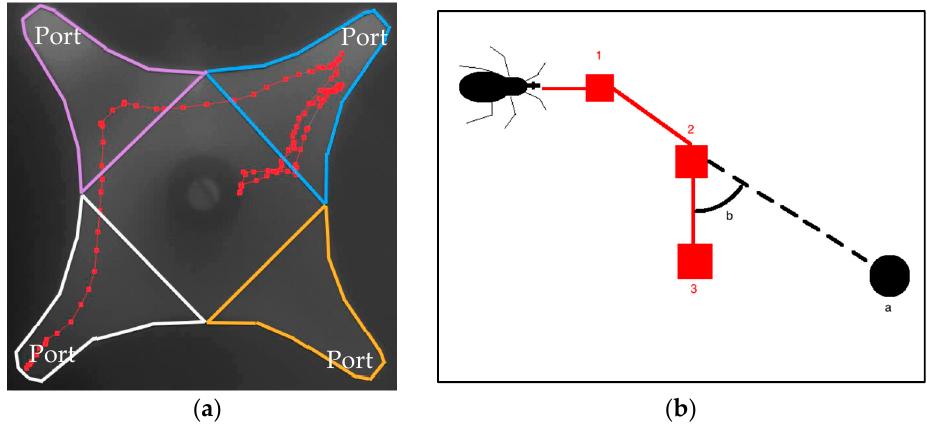
Figure 1. View of arena of the four-port olfactometer. ( a ). Four bell-shaped zones were delimited near olfactometer ports. The activity of individual insects in each zone was captured by a camera and used by EthoVision ® XT to generate behavioral parameters; ( b ). The diagram shows how deviation path was calculated in CO 2 assays. As a kissing bug walks and tracking samples are produced (in red), the mean deviation b from a point of interest a is calculated. The dotted line (in black) represents a zero-deviation path to the point after sample 2.